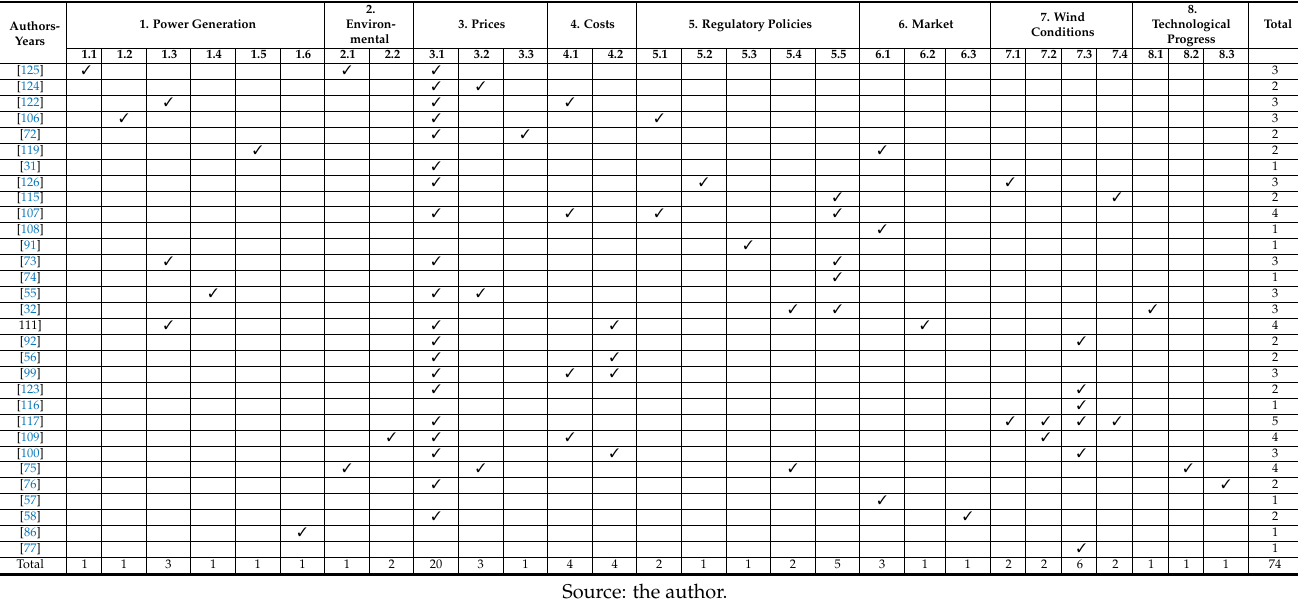
Table 5. Type of uncertainties explored in research with a real options